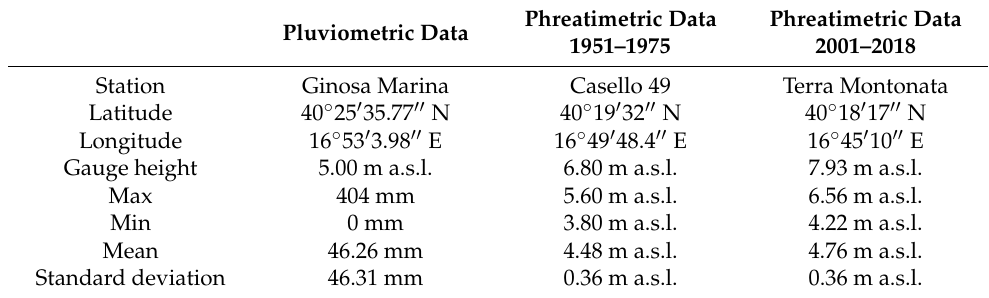
Table 1. Data details and main statistics on monthly data, statistics of pluviometric data referred to the sampling periods of 1951–1975 and